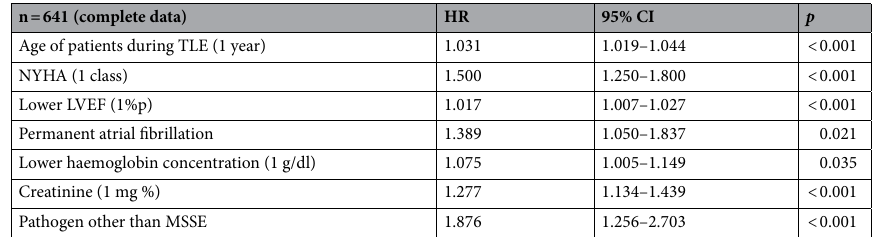
Table 2. Risk factors for deaths after TLE in LRIE patients. Results of multivariable stepwise Cox regression model. LRIE, lead related infection endocarditis, LVEF, left ventricular ejection fraction, MSSE, methicillin sensitive S. epidermidis ; NYHA, New York Heart Association (class), TLE, transvenous lead extraction.